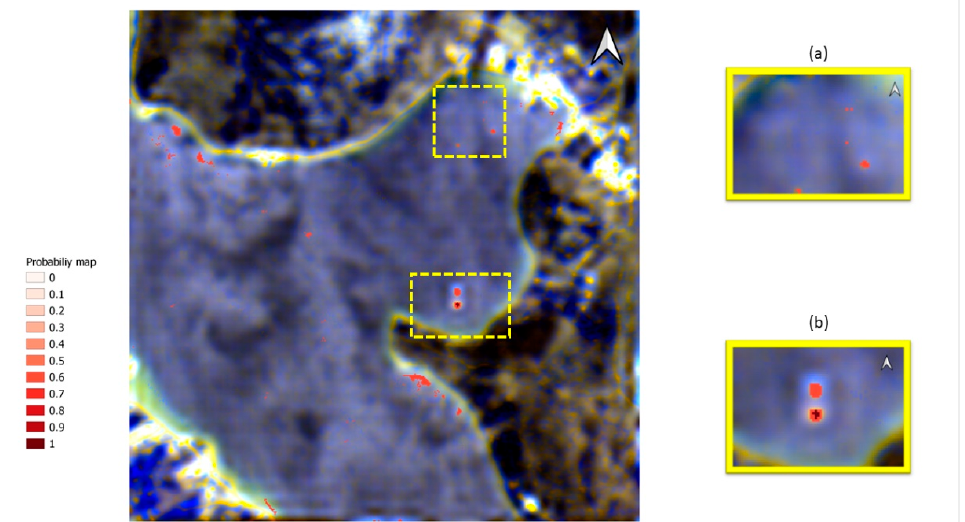
Figure 11. The output of the re-trained LGBM+K-Means with values (red pixels) representing the probability of a floating object (from 0 to 1). With re-trained algorithms, it was possible to obtain more accurate results. ( a ) A zoom of floating objects. ( b ) shows the two targets that were detected with high probability.